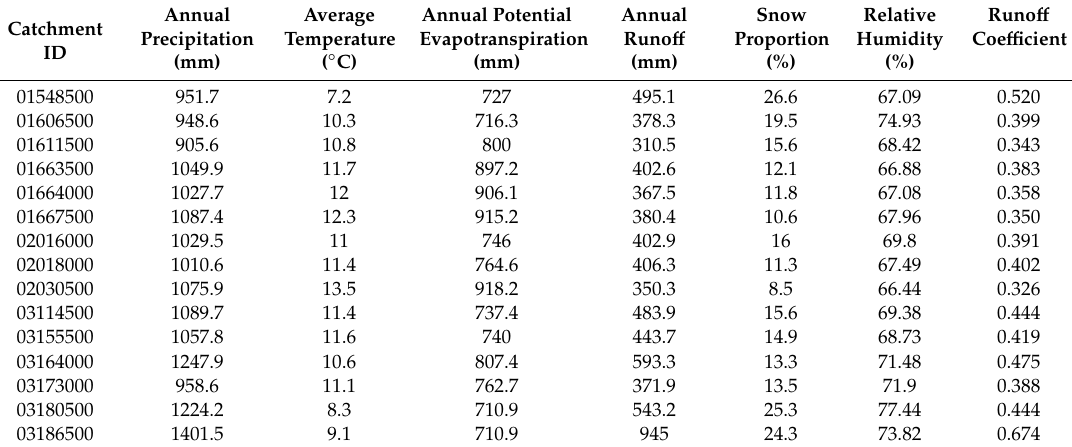
Table 2. Meteorological conditions for the 15 selected MOPEX